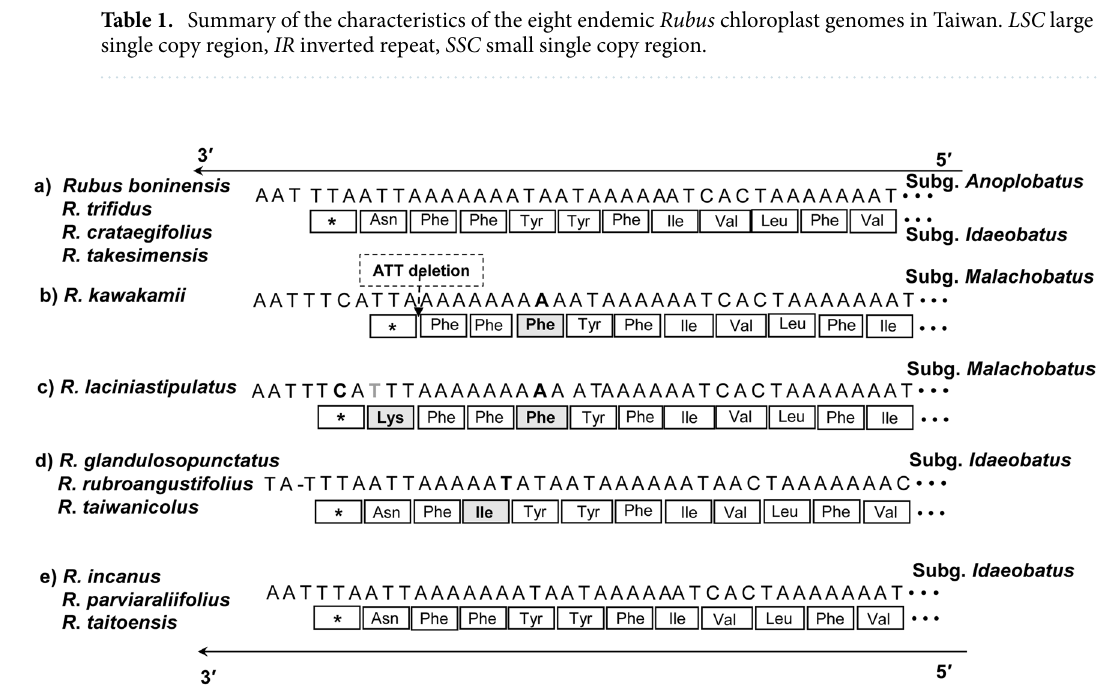
Figure 2. The 3 ′ region of ndhF genes of 12 Rubus species. In each lane, aligned DNA sequence data are shown on the top, box present the amino acid sequences that are coded from the DNA sequences, and asterisk (*) denotes the terminal codons. The mutated residues and amino acids are